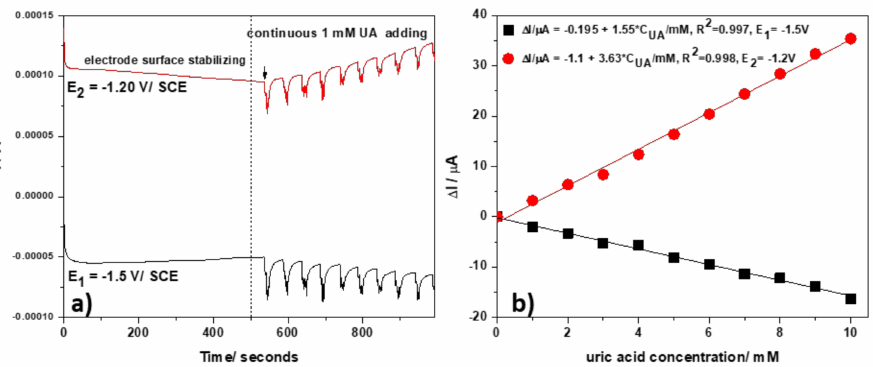
Figure 9. ( a ) Multiple-pulsed amperograms (MPAs) recorded with the PE_03 paste electrode in 0.1 M NaOH supporting electrolyte and in the presence of continuous adding 1 mM UA; the detection potential levels of: E1 = − 1.50 V/SCE (pulse time of 0.1 s), and E2 = − 1.20 V/SCE (pulse time of